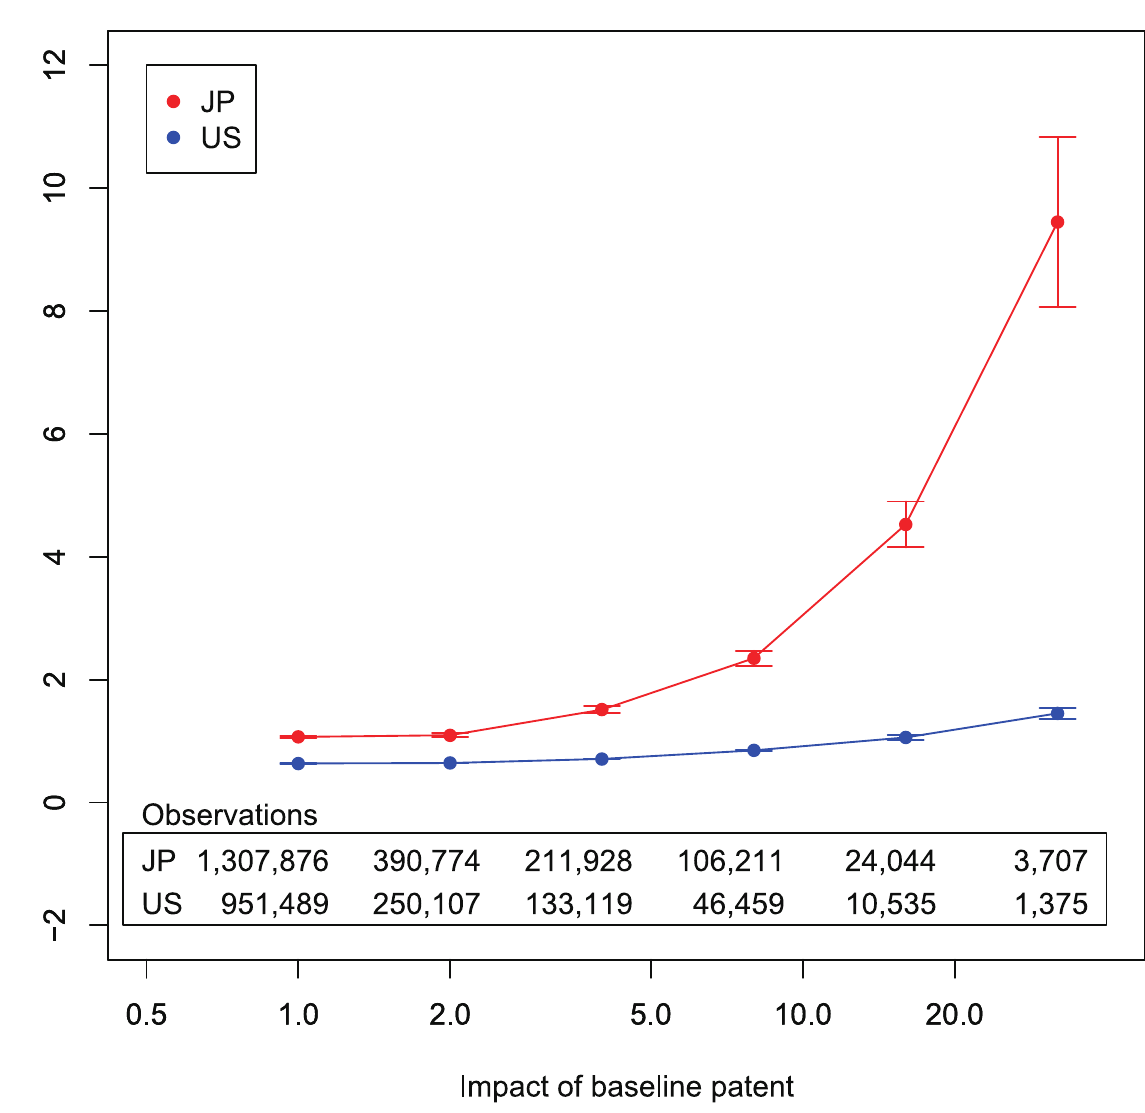
Fig 5. Average number of patents made by a team after it achieves a patent of a given impact. Horizontal axis is the impact of baseline patent. Vertical axis is average number of subsequent patents by same team. Brackets show standard errors. Horizontal axis is cut so that number of samples is greater than approximately 100.